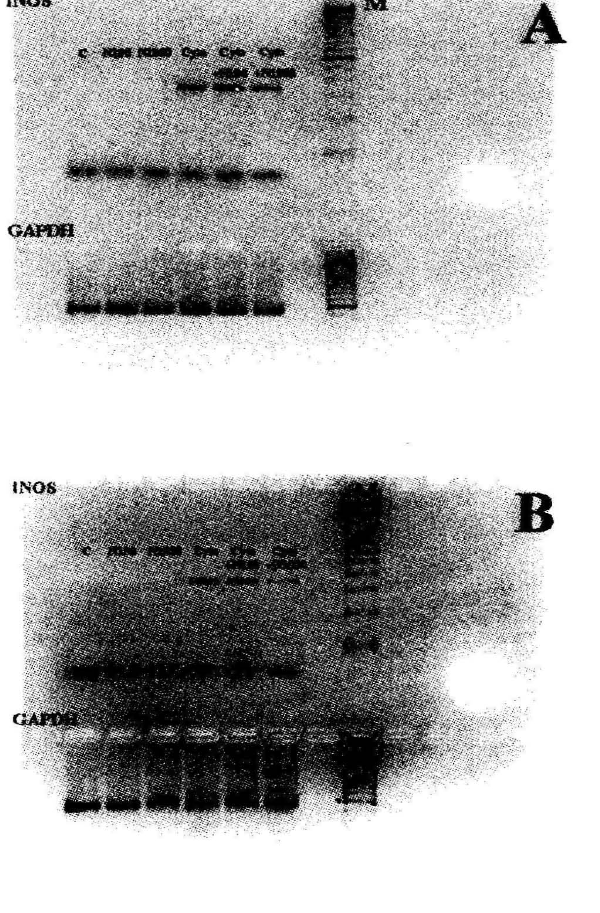
Figure 1: Qualitative analyses of inducible nitric oxide synthase gene expression detected as iNOS eDNA (length of fragment: 342 base pairs) in OVCAR-3 (Panel A) and HOC-7 (Panel B) cells. Cells had been treated for 24 h with neopterin at concentrations of 100 flM (N100) and 1000 flM (NI000), a cytokine mixture (Cyto), or with the combination of the cytokine mix ture and 100 flM neopterin (Cyto + NIOO) as well as 1000 11M neopterin (Cyto + NI000), respectively. C represents the result of a control experiment, M indi cates a size standard (I 00 base pair ladder). Results are representative of five different experiments. Cytokine mixture = interferon-y (I 00 U/mI) + interleukin-ll3 (10 U/ml) + tumor necrosis factor-a. (500